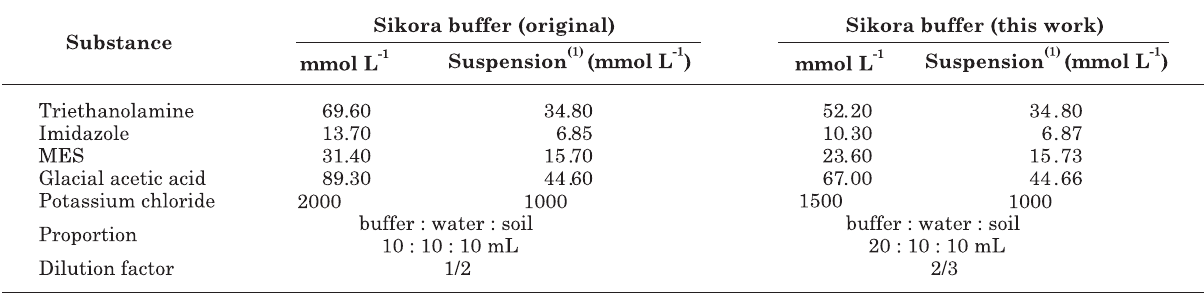
(1) Concentration in the soil